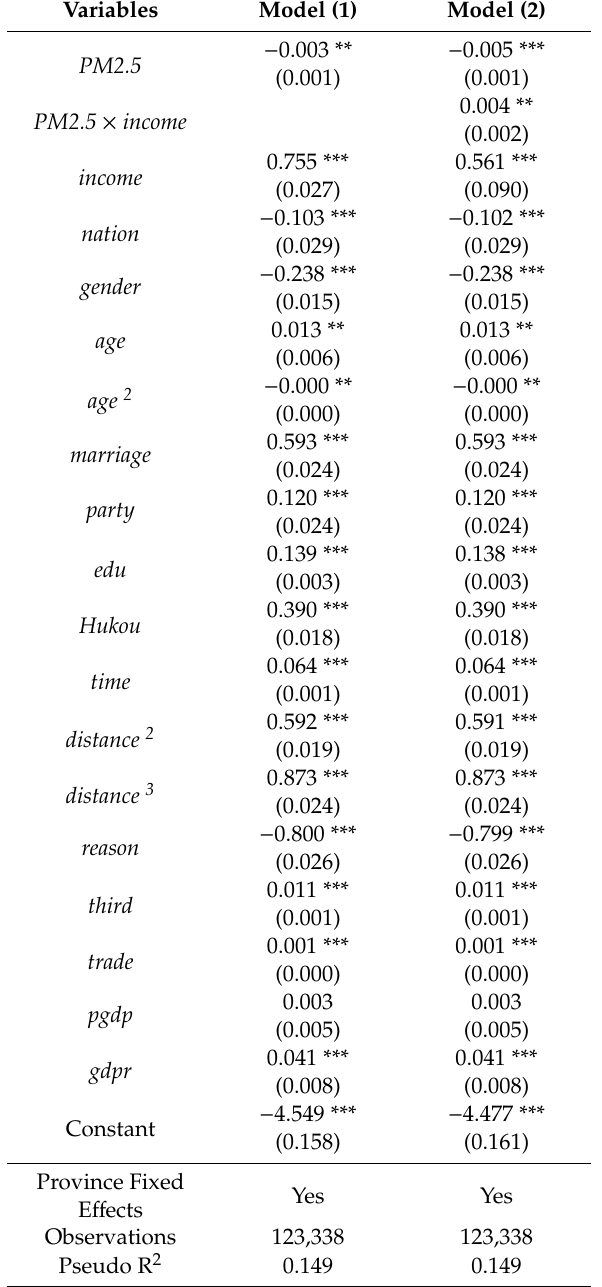
Table 4. Results of baseline regression for factors influencing the settlement intentions of Chinese migrants in